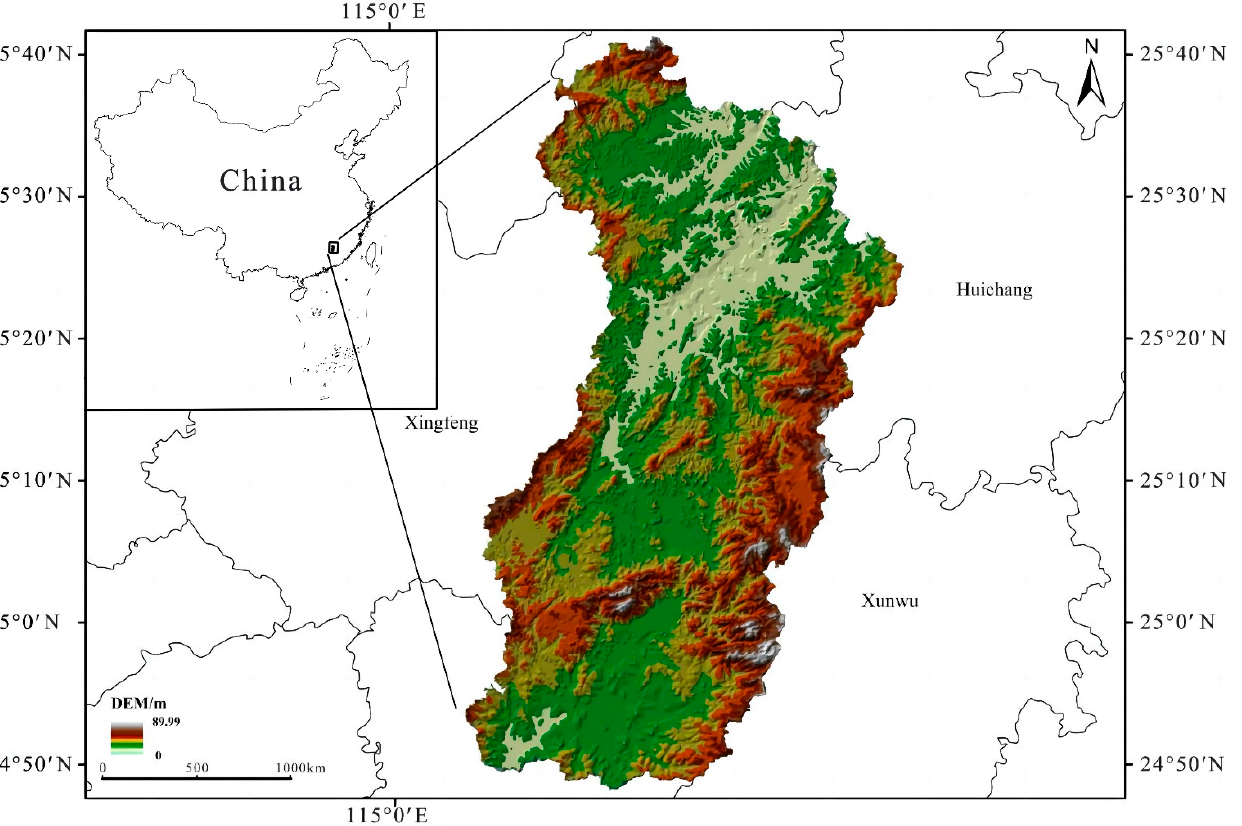
Figure 1. Topographical and geomorphological map of the study area (Anyuan County, Jiangxi Province, China). DEM, digital elevation